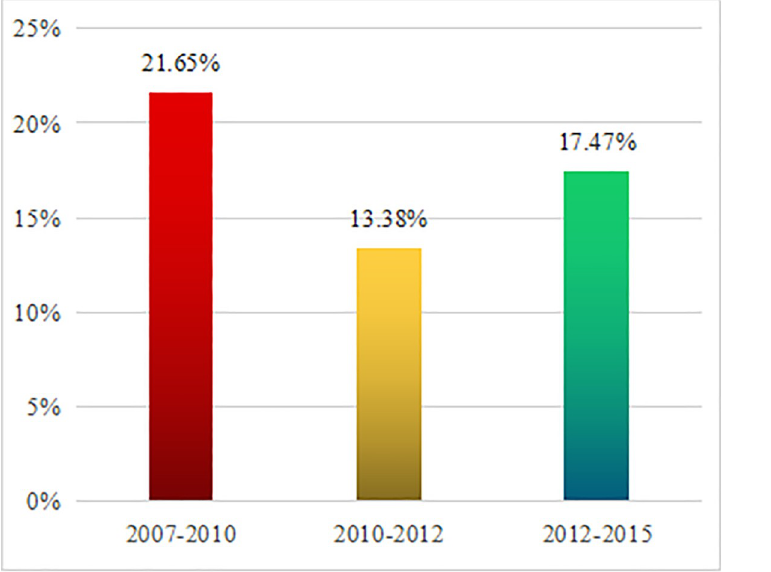
Fig 1. The growth rate of energy-related CO 2